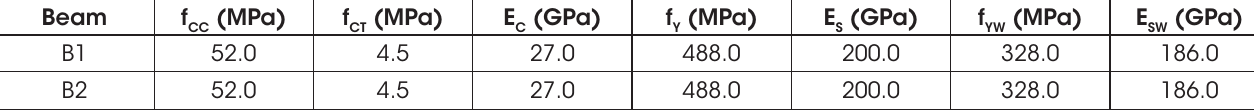
Concrete and steel proprieties adopted in the beams tested by Au e Bai [7] Beam